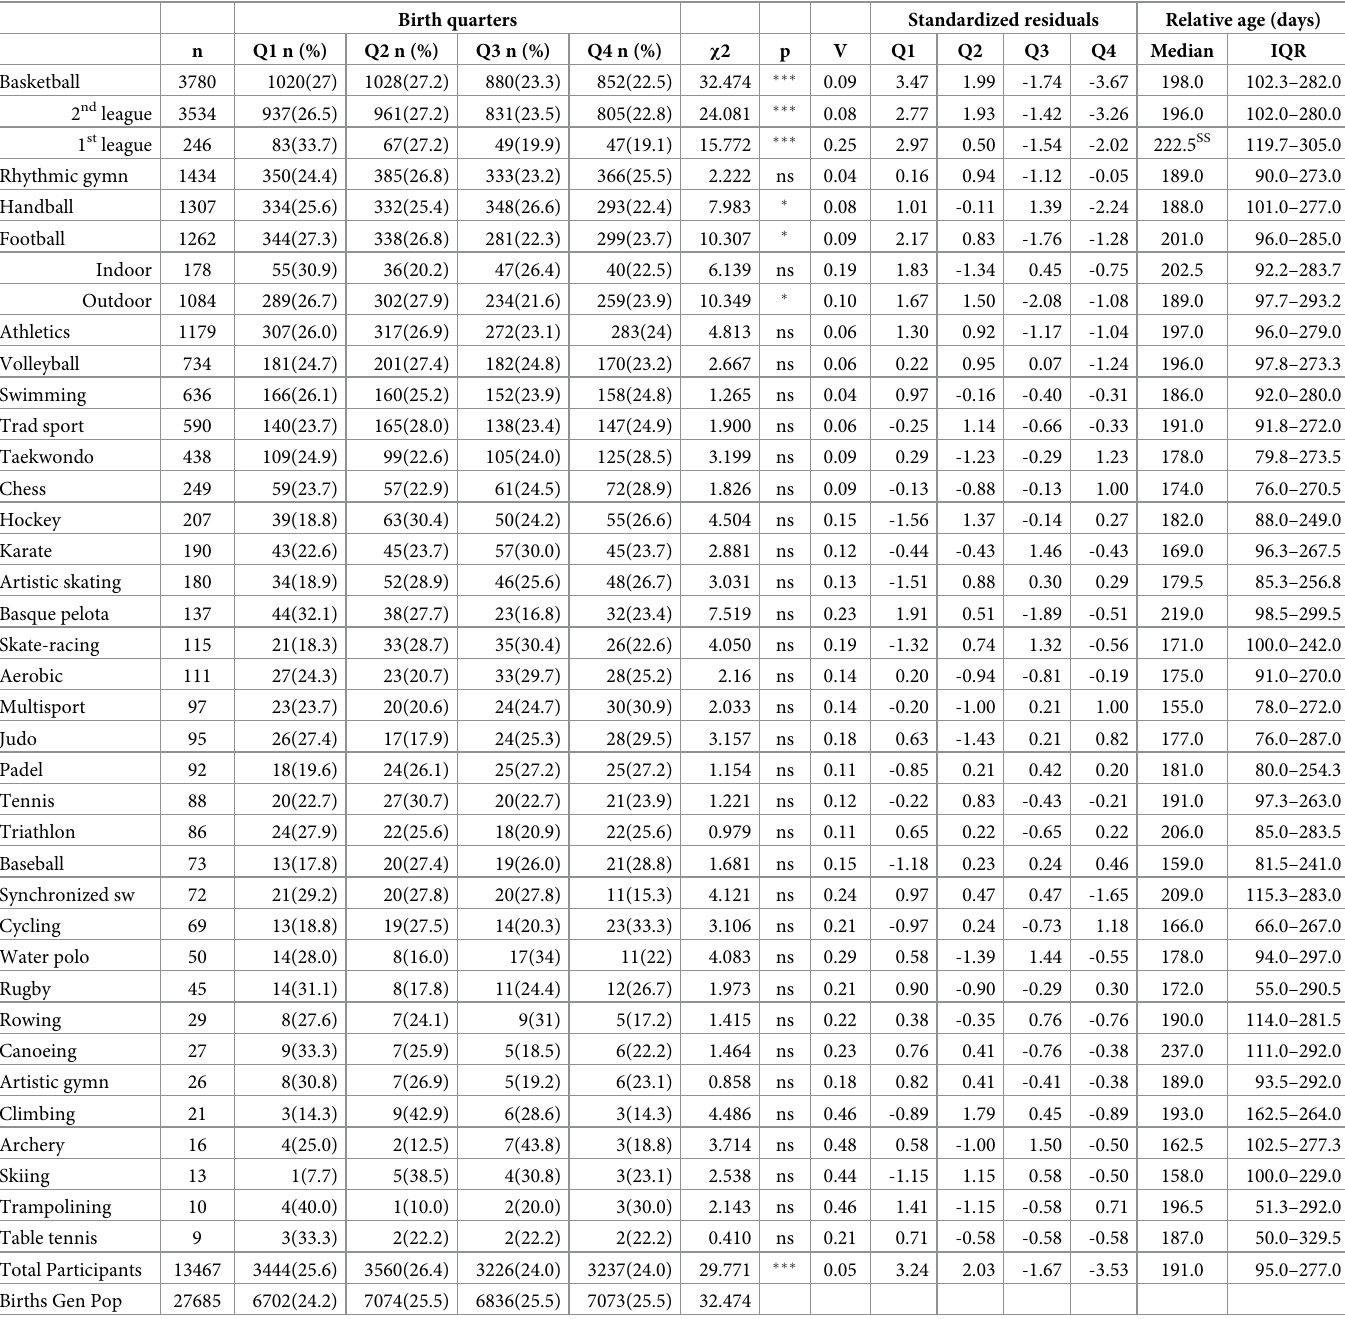
Table 4. Descriptive statistics of the birth distribution of female sport participants and the general